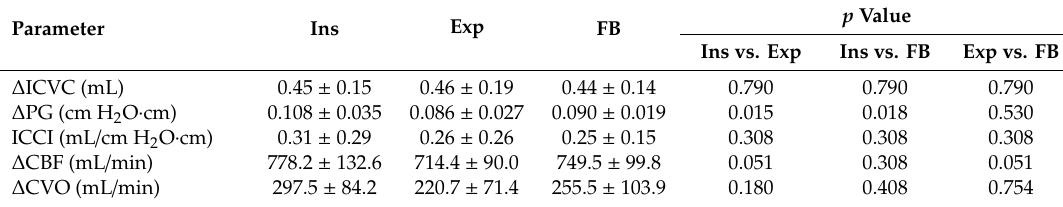
Table 2. Comparisons of fast PC-cine MRI during breath holding at full inspiration (Ins) and at the end of expiration (Exp) and during free breathing (FB) in terms of peak-to-peak intracranial volume change ( ∆ ICVC), peak-to-peak pressure gradient ( ∆ PG), intracranial compliance index (ICCI), peak-to-peak cerebral blood flow ( ∆ CBF), and peak-to-peak cerebral venous outflow ( ∆